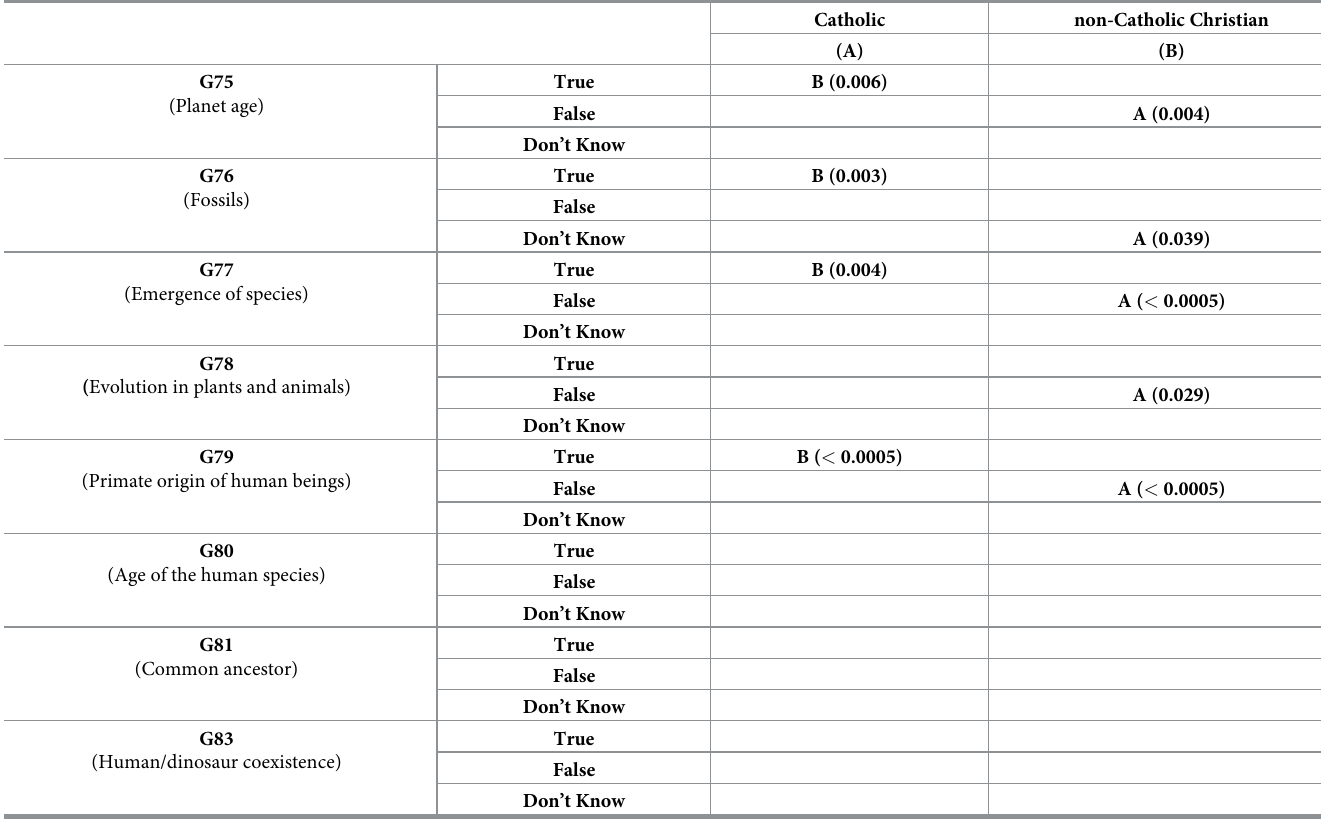
Table 4. Proportion column tests (Brazilian Catholics and